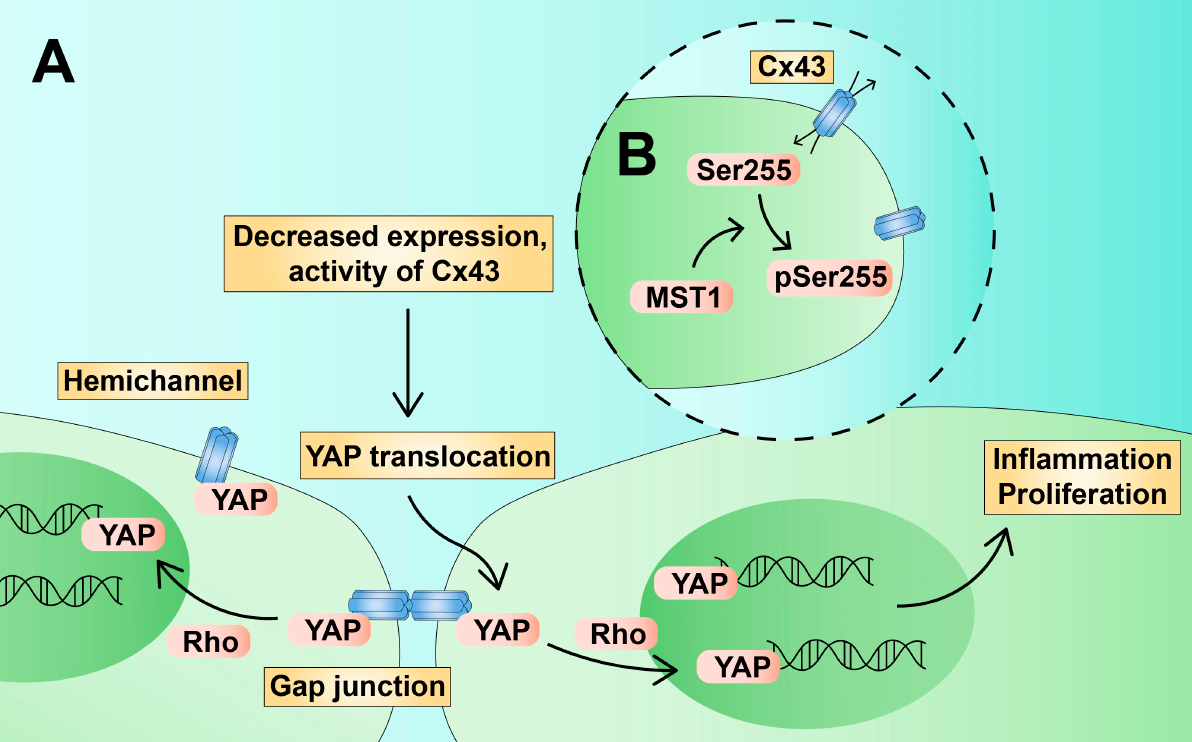
Figure 3. Hypothetical impact of decreased expression or activity of Cx43 on YAP translocation and induction of a pro-inflammatory state of the endothelium. ( A ): Quiescent endothelium with the YAP protein anchored on Cx43. Cx43 downregulation promotes YAP translocation into the nucleus. ( B ): Inhibition of Cx43 via Ser255 phosphorylation by MST1. Cx43—connexin 43; YAP—Yes-associated protein.